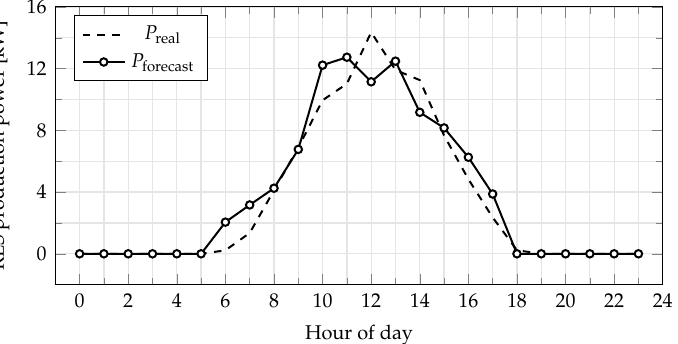
Figure 3. RESPOND production forecasting service output performance for an Aarhus photovoltaic (PV)